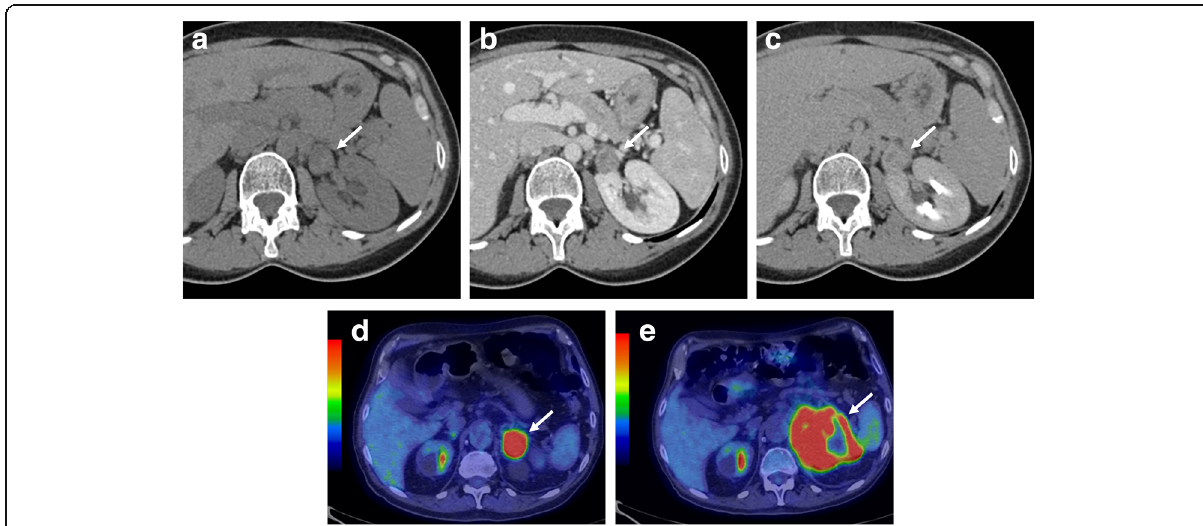
Fig. 10 Left adrenal metastasis in a 62-year-old woman with lung cancer. Unenhanced CT ( a ), portal ( b ), and late phase ( c ) images show a left adrenal mass (arrow) with attenuation value of 26 HU on unenhanced CT ( a ) and “ absolute percentage washout ” of 15%. Staging 18 F-FDG PET/CT ( d ) performed 3 months later revealed a left adrenal lesion (arrow) with high metabolic activity (SUV max 14 g/mL) and increased in size in comparison with CT images. After chemotherapy, restaging 18 F-FDG-PET/CT ( e ) showed morpho-functional disease progression of the adrenal lesion (arrow) with signs of central necrosis (SUV max 19 g/mL with central necrotic area of absence of 18 F-FDG uptake). Images of 18 F-FDG-PET/CT provided by database of Nuclear Medicine Service, Fondazione Istituto G. Giglio, Cefalù,